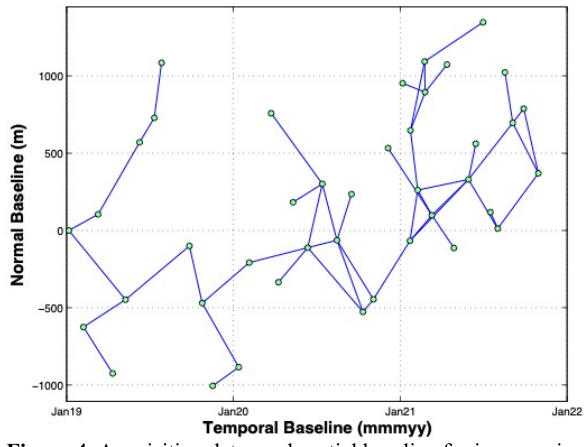
Figure 4 . Acquisition dates and spatial baseline for image